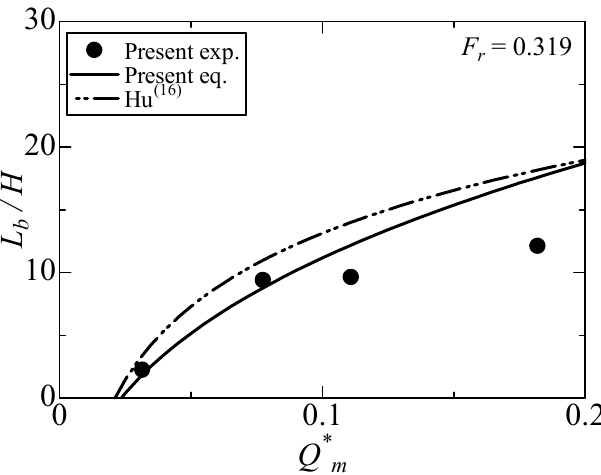
Fig. 8 Relationship between Q * m and L b / H when Fr = 0.319. The solid line, double-dashed chained line, and black circles represent our newly proposed Eq. (3), Hu et al.’s Eq. (4), and the experimental results calculated from Fig. 7,